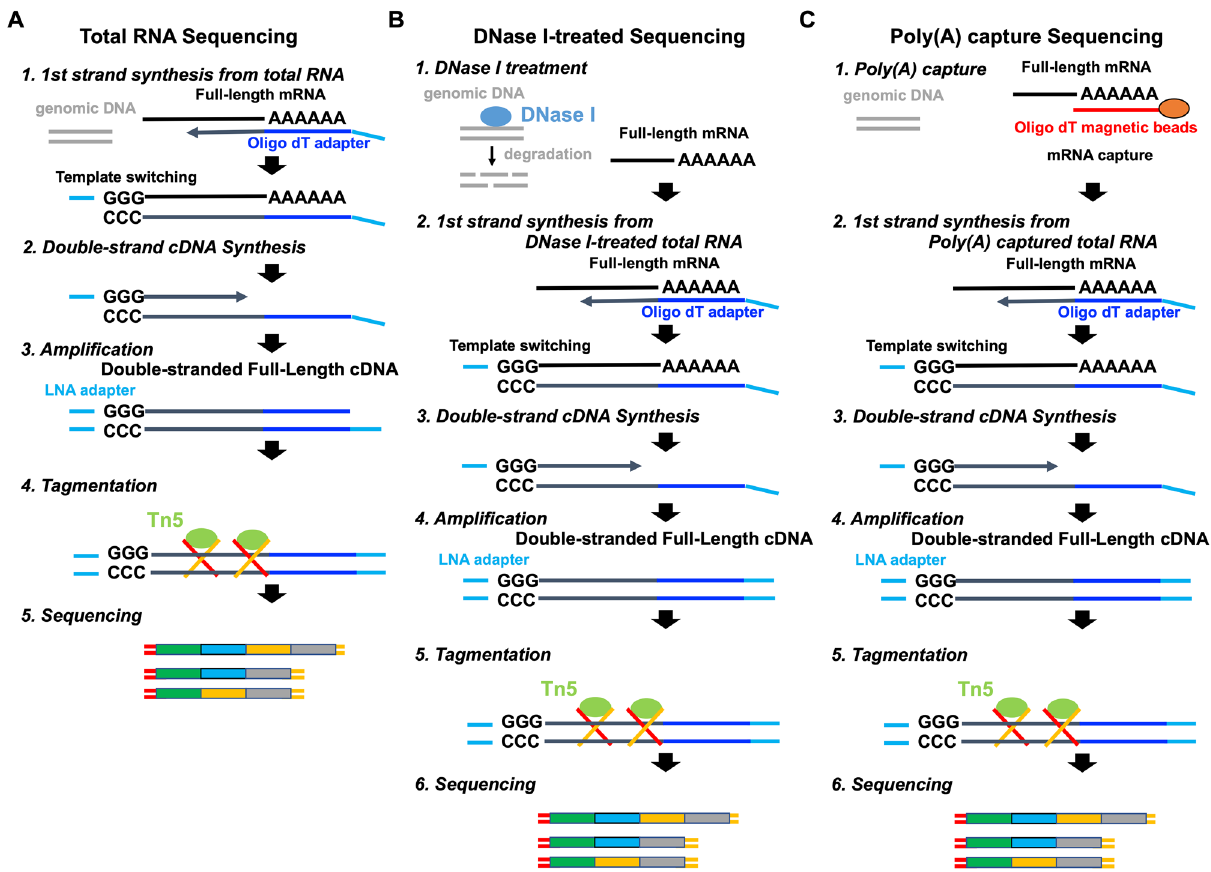
Figure 1. Library preparation workflow. ( A ) Workflow for Total RNA Sequencing. ( B ) Workflow for DNase I-treated Sequencing. ( C ) Workflow for Poly(A) capture